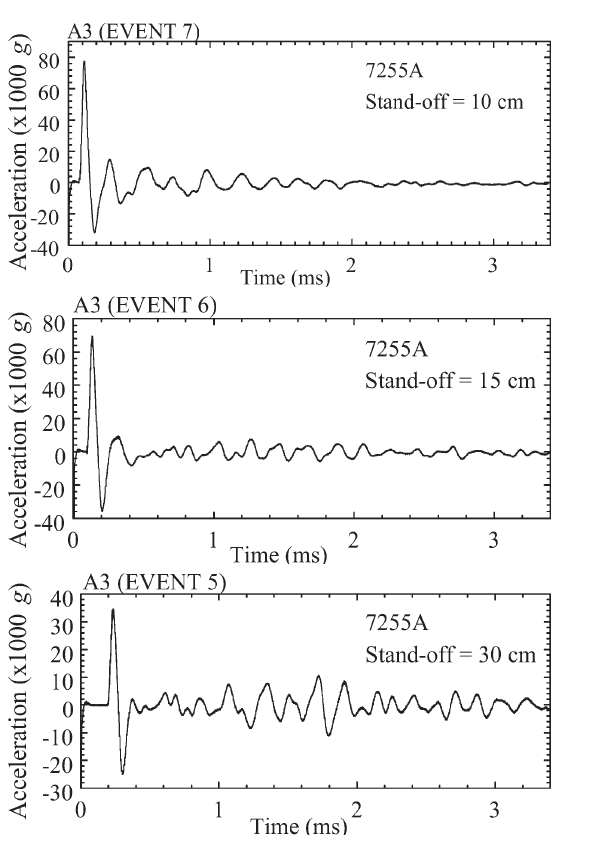
Fig. 12. Measurements at location A3 using 5 g of PE4 explosive, at 10, 15 and 30 cm stand-off.